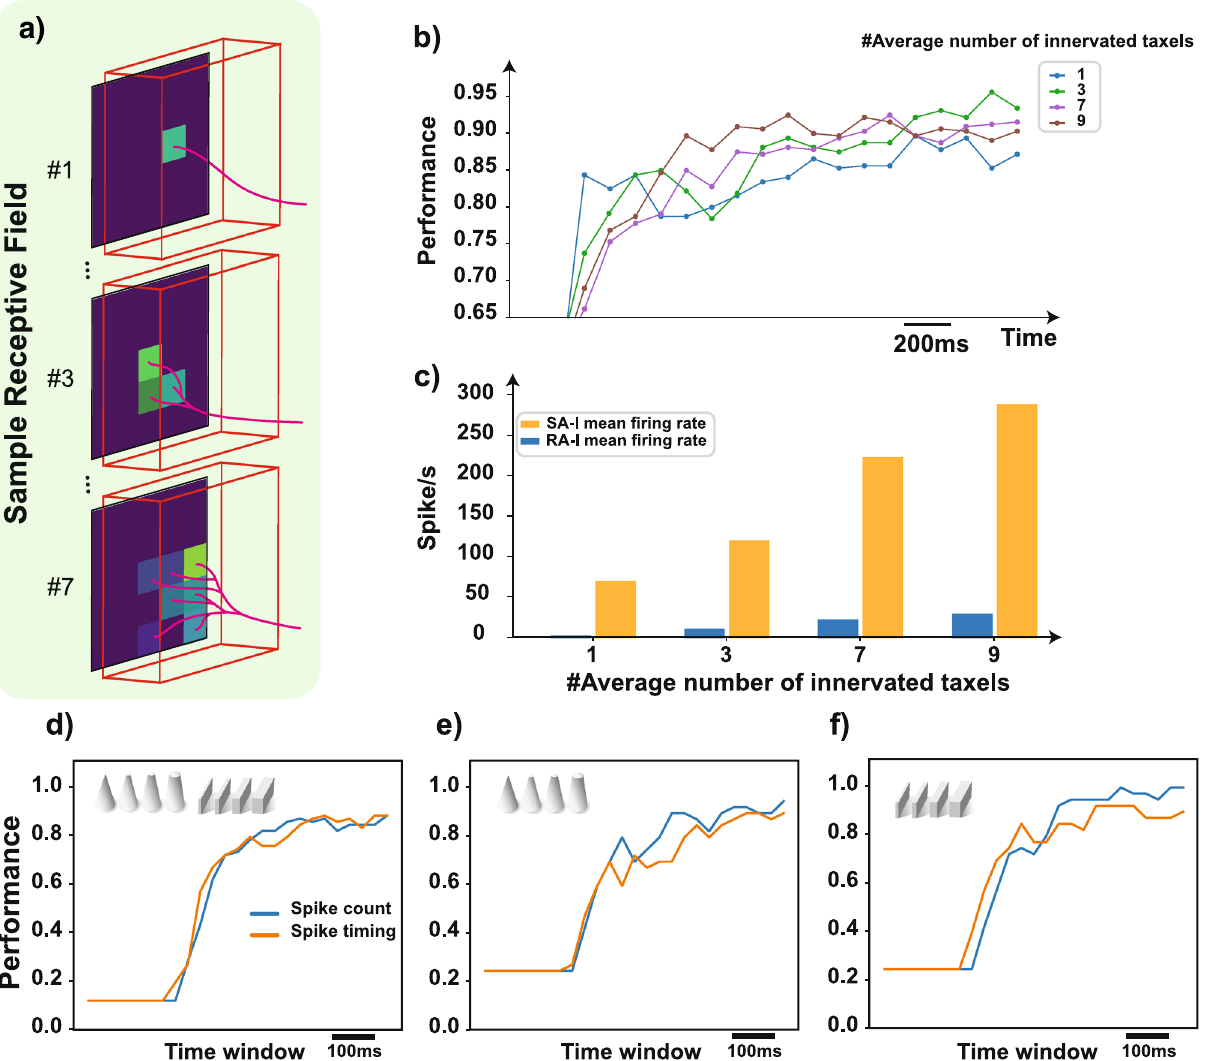
Figure 3. The impact of the innervation on the classification performance of the robotic data. ( a ) The samples of the receptive field for SA-I and RA-I afferents innervate the tactile sensor elements (taxels). ( b ) Classification performance of digital SA-I and RA-I afferents in distinct time windows when the receptive field size is changed. Spike count algorithm is used right after the sharp objects are touched by the sensor. ( c ) The firing rate with respect to the variation in receptive field size. Classification performance of ( d ) all objects, ( e ) Group-I objects, and ( f ) Group-II objects for the total population in different time windows using spike count (blue) and spike timing (orange) algorithms when three taxels are innervated by the digital afferents on